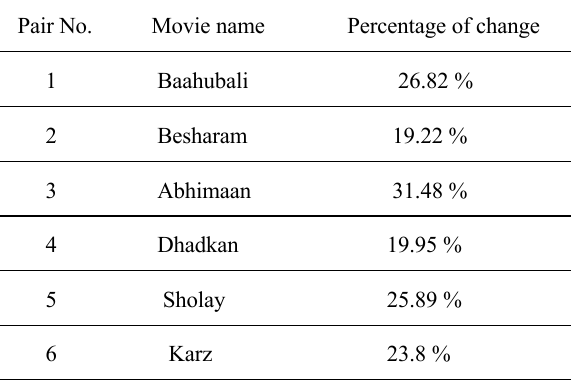
Table 6: Changes in saccade amplitude (pixels) in AOI_Video Pair